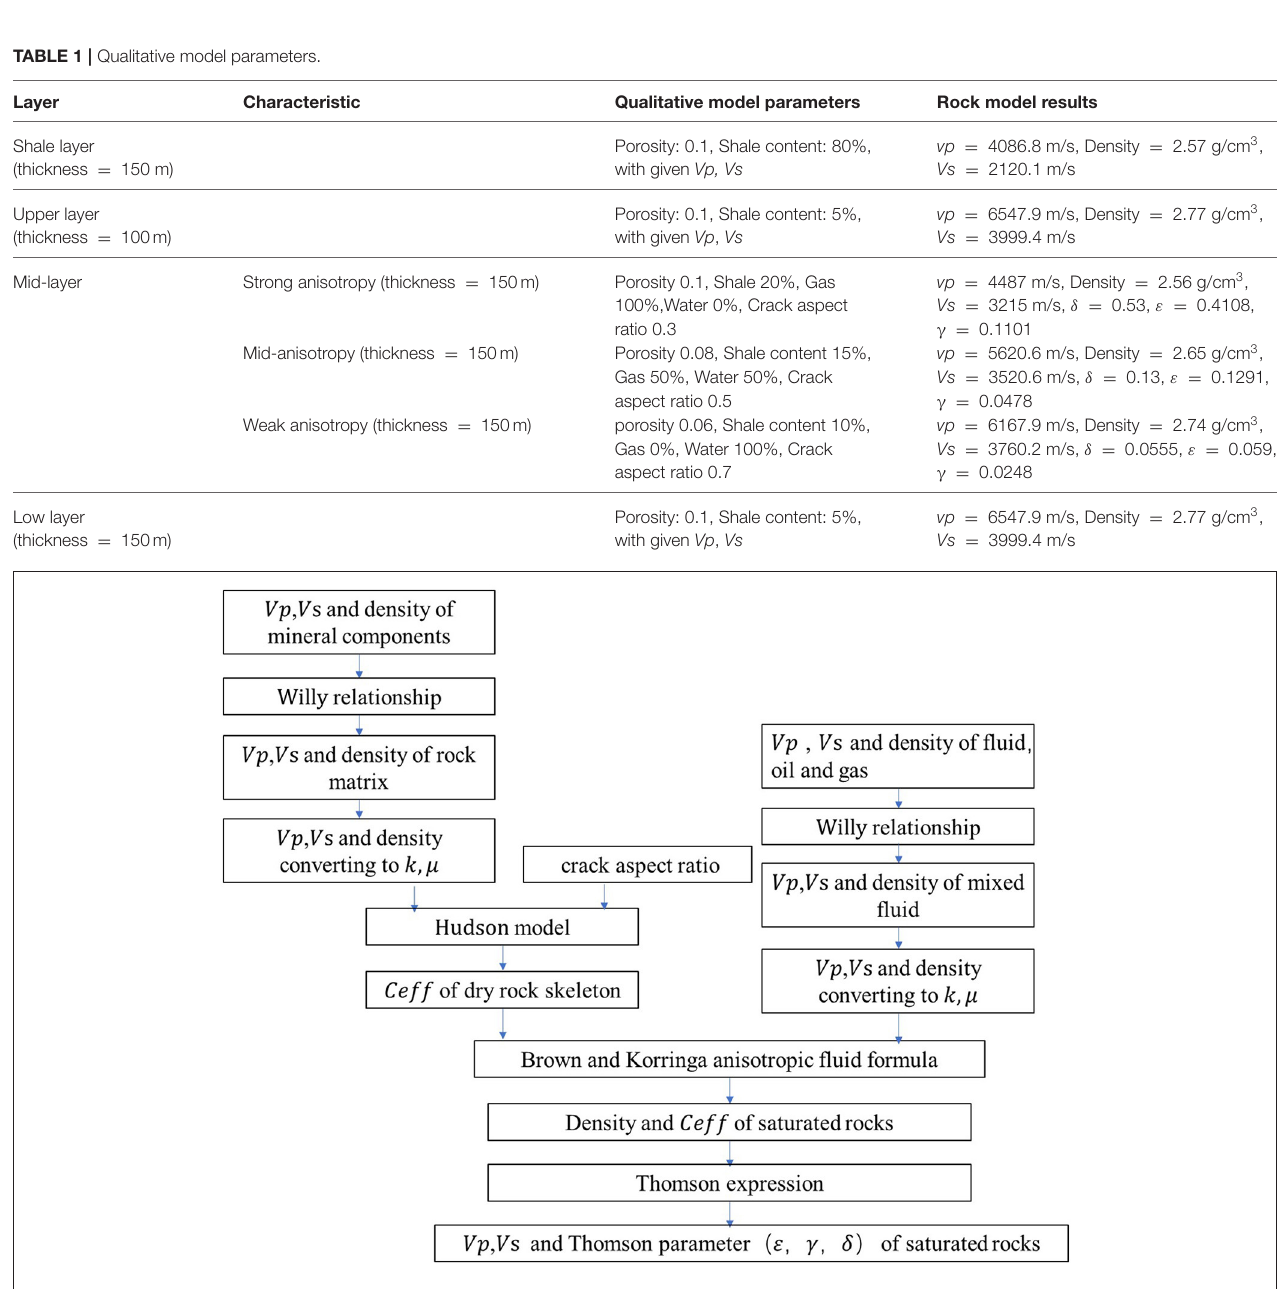
FIGURE 2 | Model building